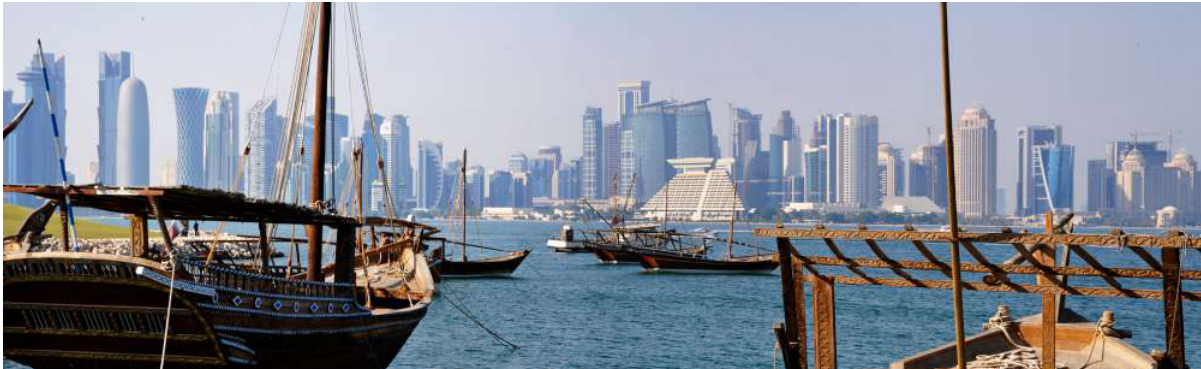
Fig. 11 West Bay seen against the tra - ditional Arabian dhow sailboat (Source: Peter Chomowicz,